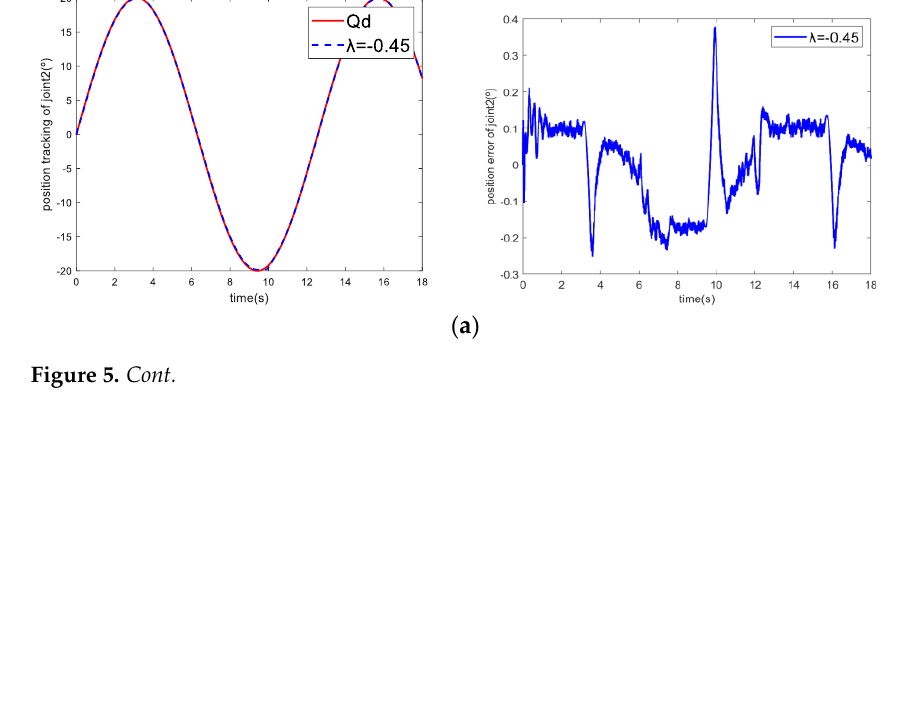
Figure 3. Joint 2 under step. ( a ) Trajectory tracking diagram; ( b ) trajectory tracking error diagram.